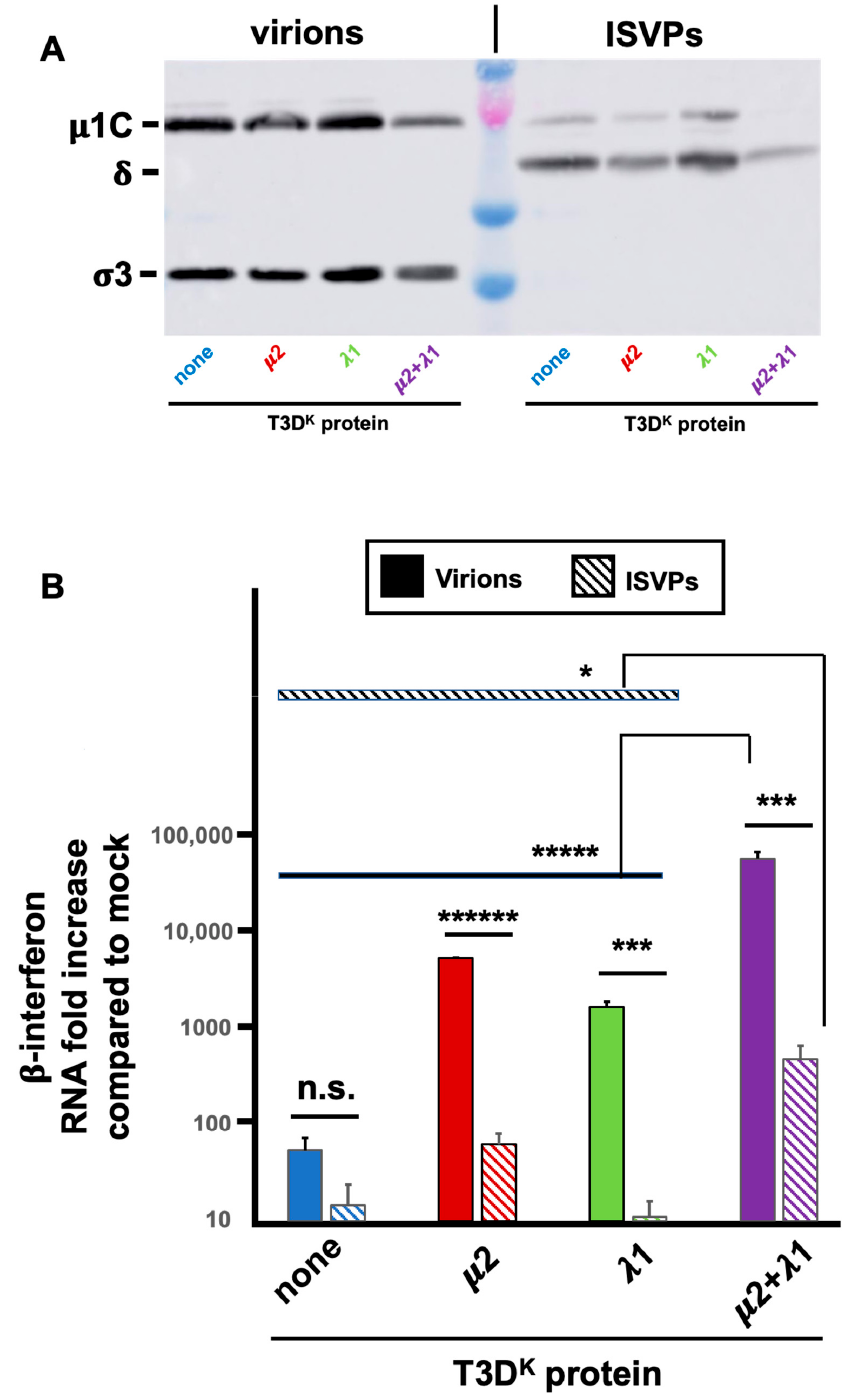
Figure 7. Comparison of virions and ISVPs. Infectious virus stocks were prepared and treated with chymotrypsin as described in Materials and Methods and used to infect L929 cells at a MOI of 10 TCID 50 units/cell. The different viruses in the T3D S genetic background with either no substitution (none) or substitution of the µ 2, λ 1 or both proteins of T3DK were compared. Total RNA and proteins were recovered and analyzed, as before and as described in Materials and Methods. ( A ) Aliquots of the virions and ISVPs stocks were examined by immunoblotting showing the disappearance of σ 3 and µ 1C to δ conversion in ISVPs for all 4 different viruses. ( B ) RT-qPCR was performed to detect β -interferon and viral M1 RNA. The experiment was done three times (biological replicates) for ISVPs and twice for virions; each reaction was then performed in triplicates (technical replicates). The